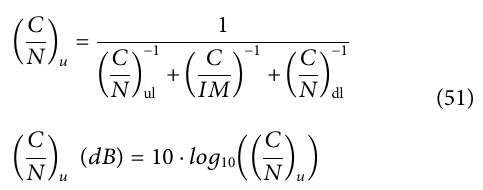
( Figure 5 ), using a traf fi c simulator developed inside our research center (Interdisciplinary Centre for Security and Reliability and Trust (SnT), 2019).